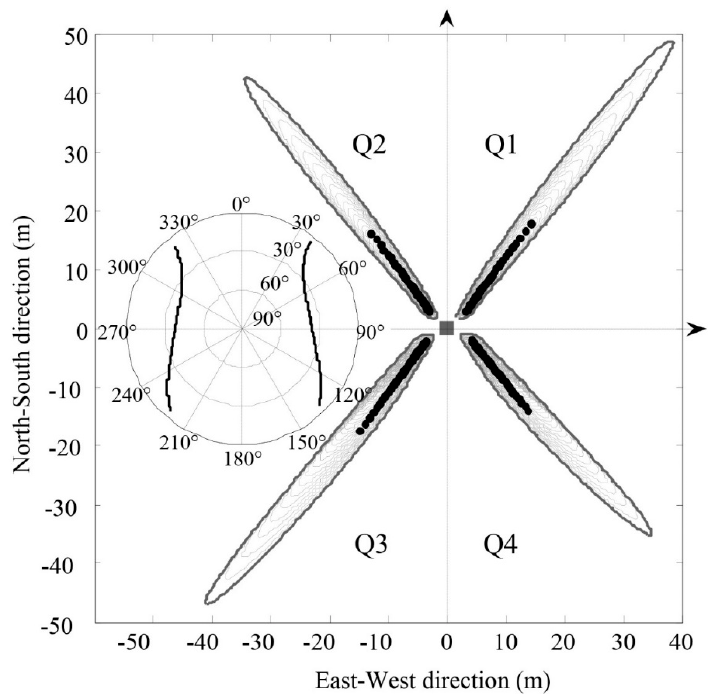
Figure 9. The specular reflection point and the first Fresnel zone of the PRN 1 satellite signal at Station P041 on 1 January 2012, where the sub-map is the sky map of the PRN 1 satellite.